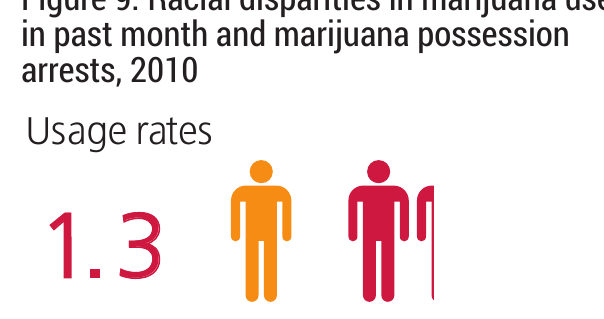
Figure 9. Racial disparities in marijuana